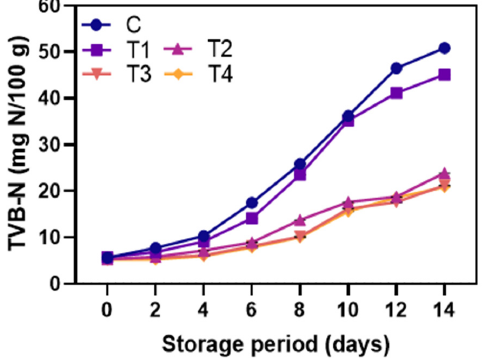
Figure 8. Changes in TVB-N value of the shrimps coated with different coatings during storage of 14 days at 4 °C. C: shrimp dipped in distilled water as control; T1: shrimp coated with alginate coating; T2, T3, and T4: shrimp coated with 0.5, 1.0, and 1.5% LPE,